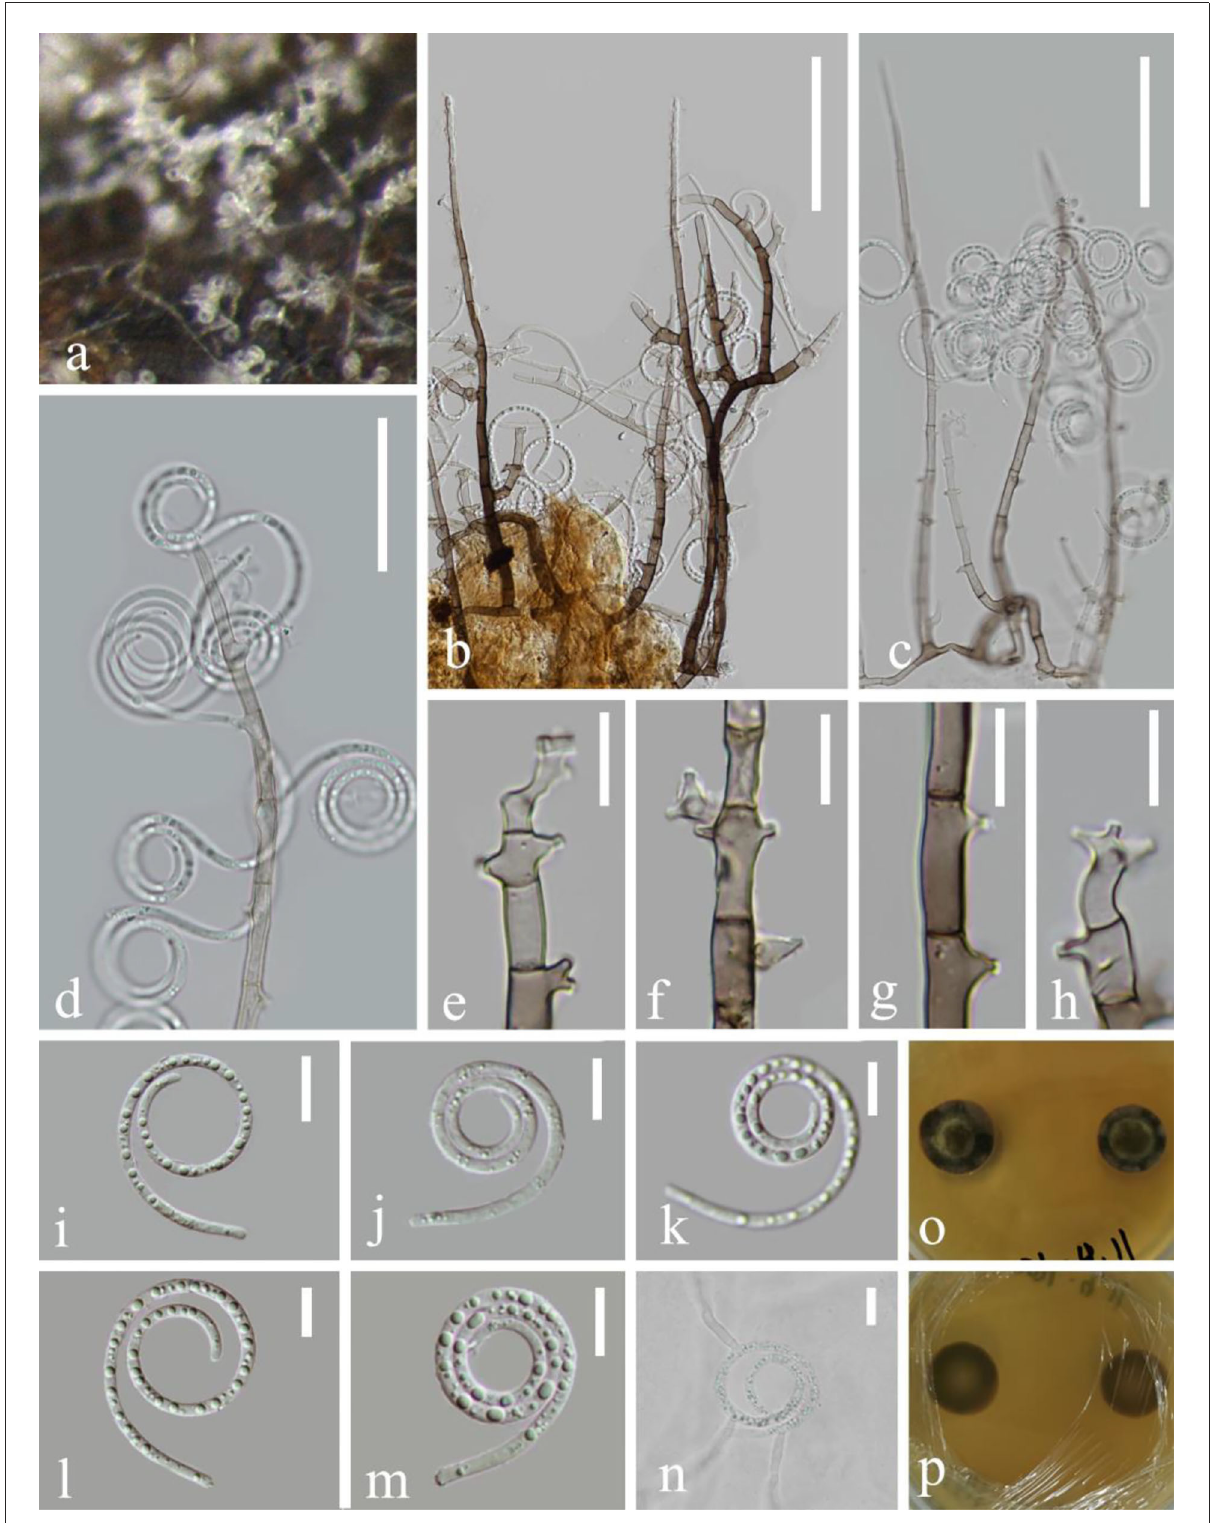
FIGURE7 Parahelicomyces suae (KUN-HKAS 124604, holotype). (a) Colony on decaying wood. (b–d) Conidiophores with attached conidia. (e–h) Conidiogenous cells. (i–m) Conidia. (n) Germinating conidium. (o,p) Colony on MEA observed from above and below. Scale bars: (b) 70 µ m,